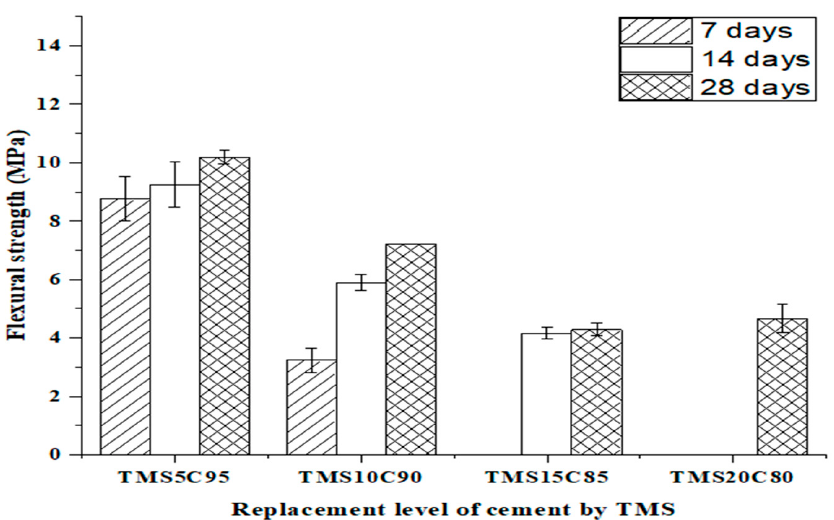
Table 3. Information obtained from the R-curves of unstabilized and stabilized TMS.